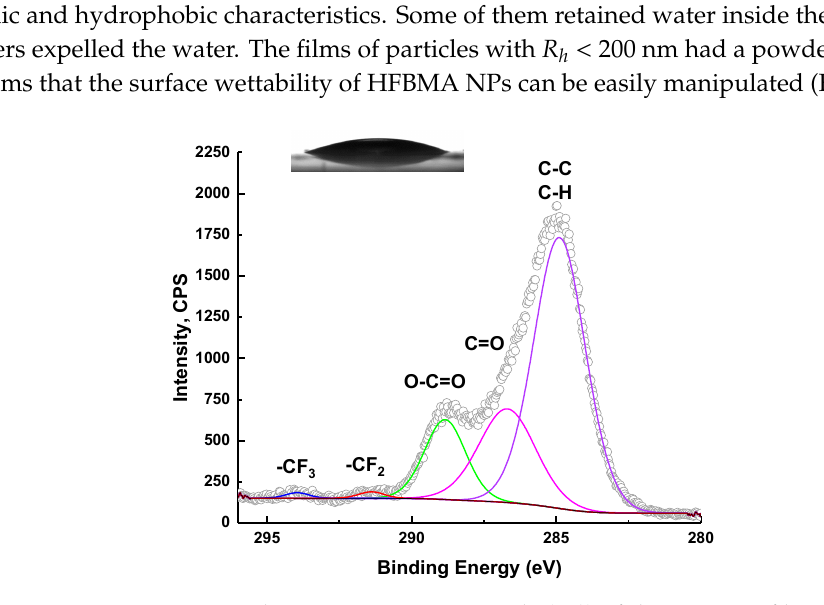
Figure 8. C 1s XPS spectra and static water contact angle (19°) of thin H36 NP film on modified glass slides.